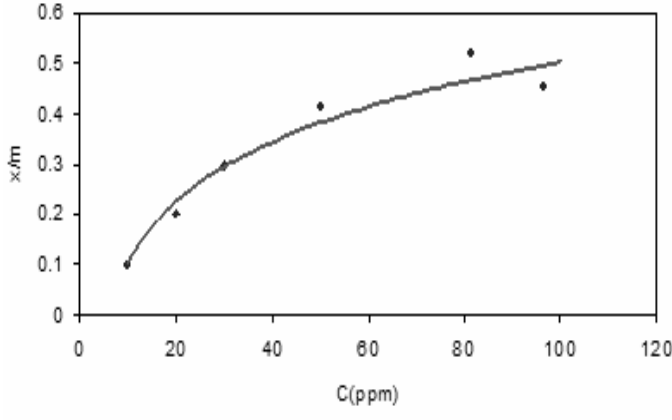
Figure 11 . Effect of initial Pb 2+ ion concentration on sorption by PANi/SD